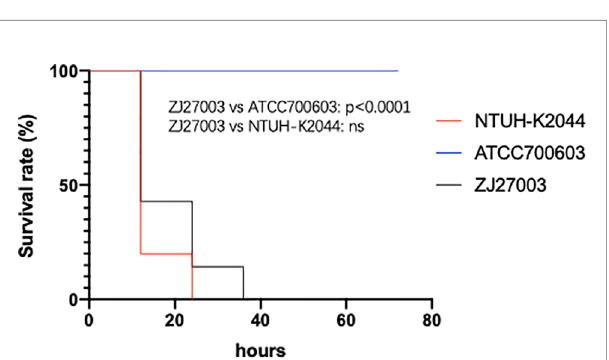
FIGURE 3 | Mouse survival rates infected with K. pneumoniae strain ZJ27003, typical hypervirulent strain NTUH-K2044 and common strain ATCC700603, respectively. Mouse were infected intraperitoneally with 1×10 7 CFU K. pneumoniae strains and monitored each 12 hours for 3 days.